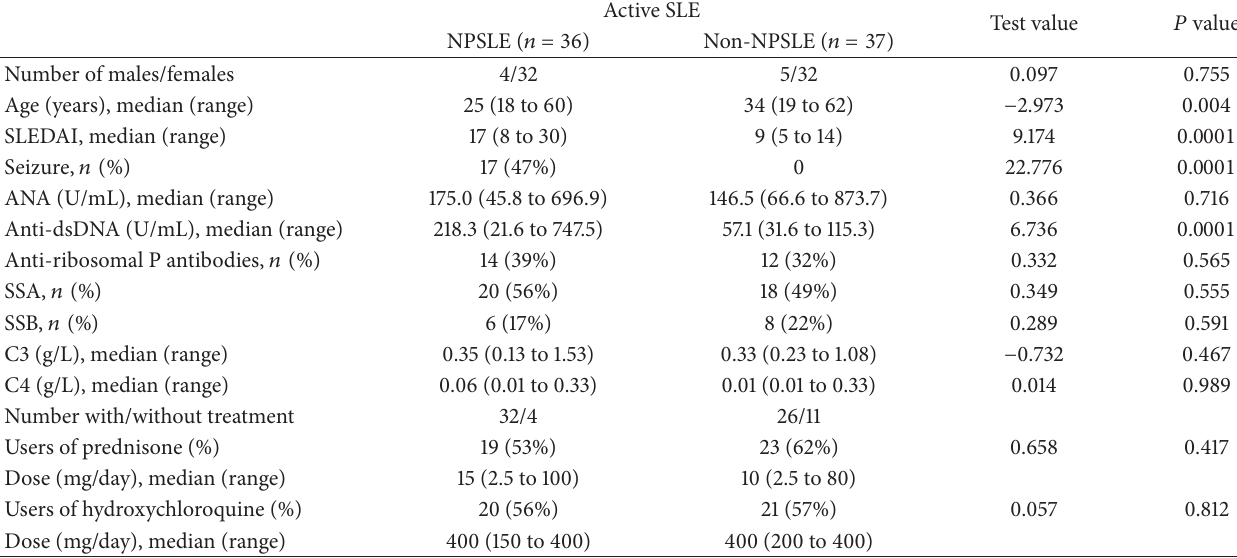
Table 2: Comparison of clinical characteristics between NPSLE and non-NPSLE in active SLE